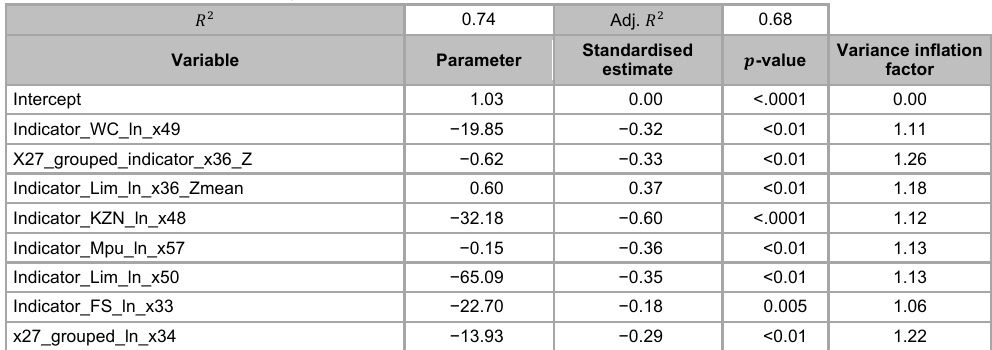
Linear-regression model with interaction effects of the HT data